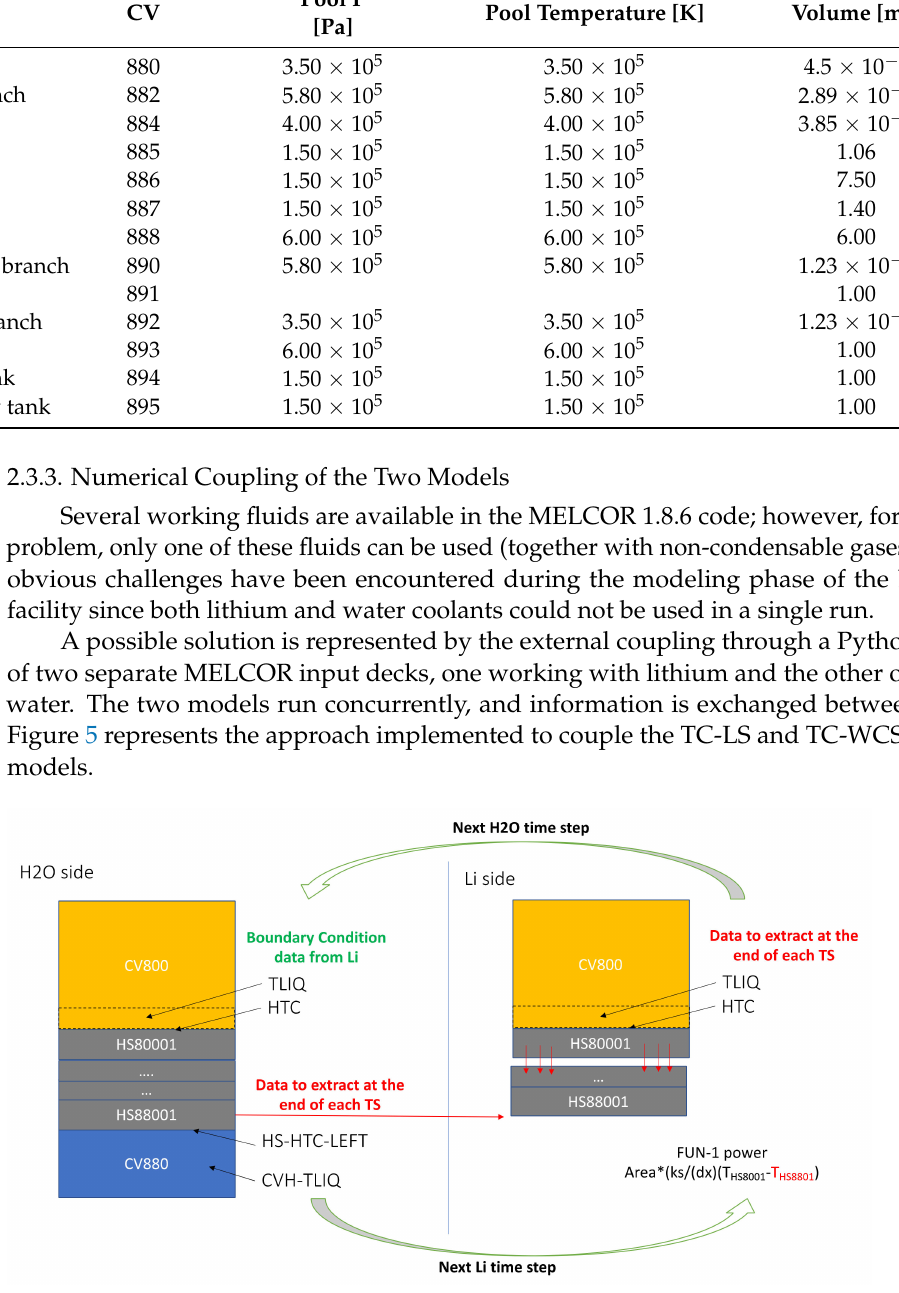
Figure 5. Scheme of numerical coupling between TC-LS and TC-WCS Melcor